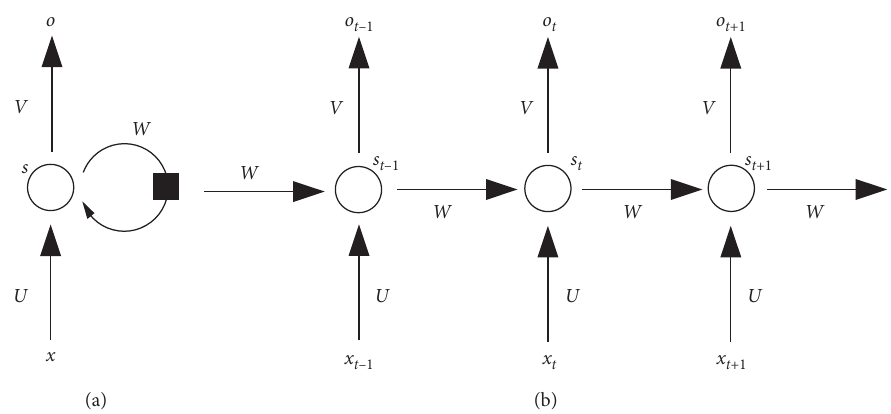
Figure 5: Schematic diagram and expanded diagram of cyclic neural network [27].